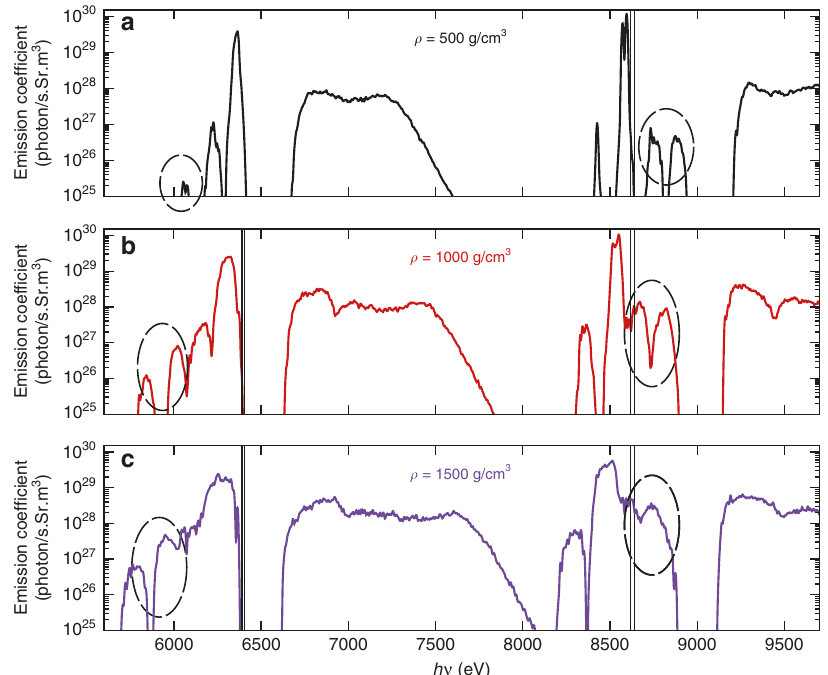
Fig. 4 Interspecies radiative transitions (IRT) versus plasma density. DFT calculations are done for superdense Fe – Zn mixtures at kT = 50 eV but different plasma mass densities: a ρ = 500 g cm − 3 , b ρ = 1000 g cm − 3 , and c ρ = 1500 g cm − 3